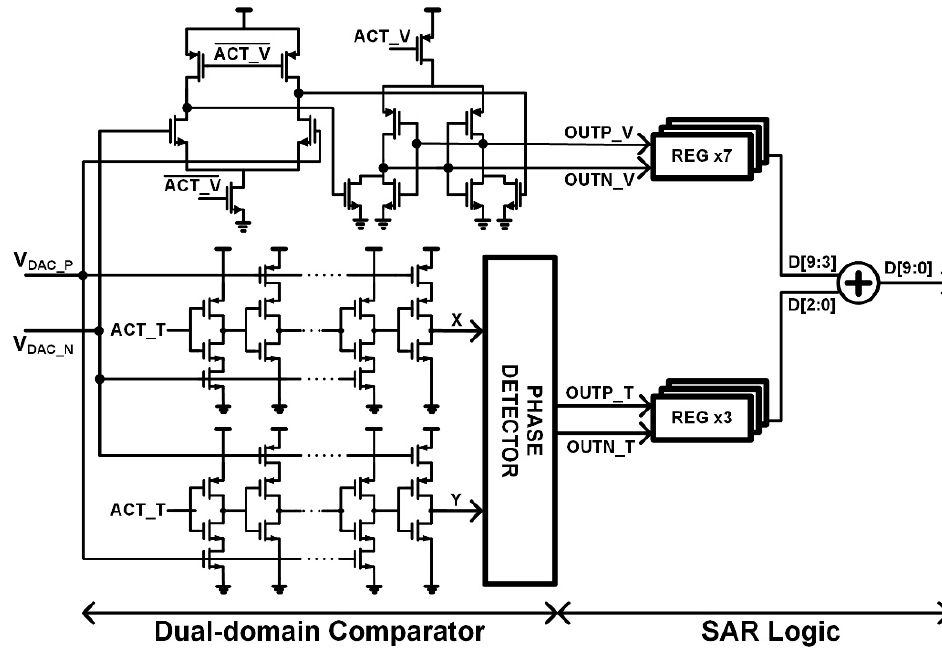
Figure 4. Architecture of the proposed dual-domain comparator.